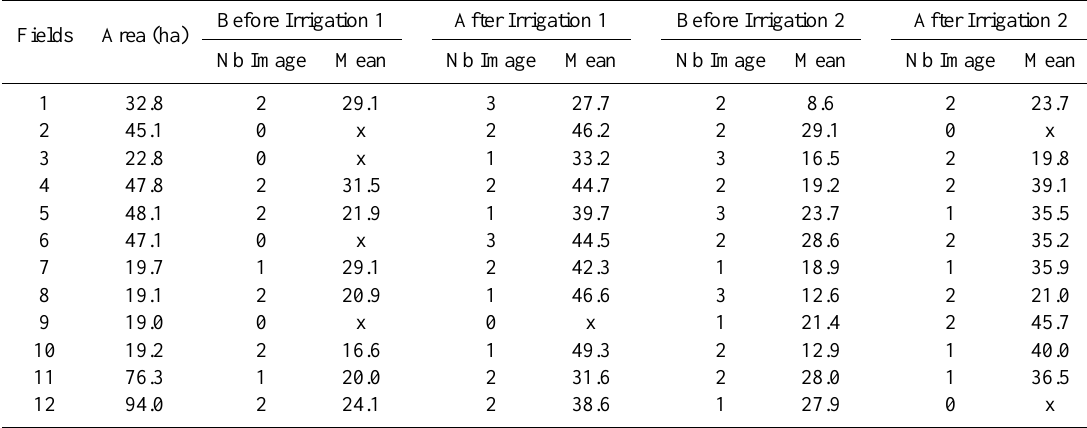
Table 3. Topsoil moisture derived from ASAR image before and after the first and the second irrigations on the twelve fields where irrigation schedules were collected during the experiment. Before Irrigation 1 After Irrigation 1 Before Irrigation 2 After Irrigation 2 Fields Area (ha) Nb